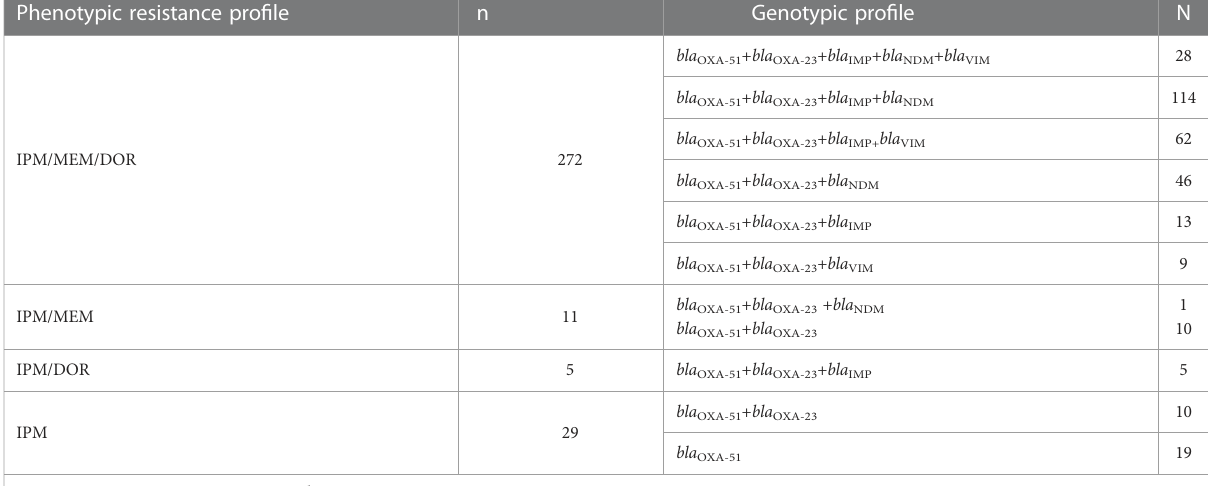
TABLE 3 The comparison of the phenotypic carbapenem resistance pro fi le and genotypic resistance pro fi le of CRAB isolates. Phenotypic resistance pro fi le n